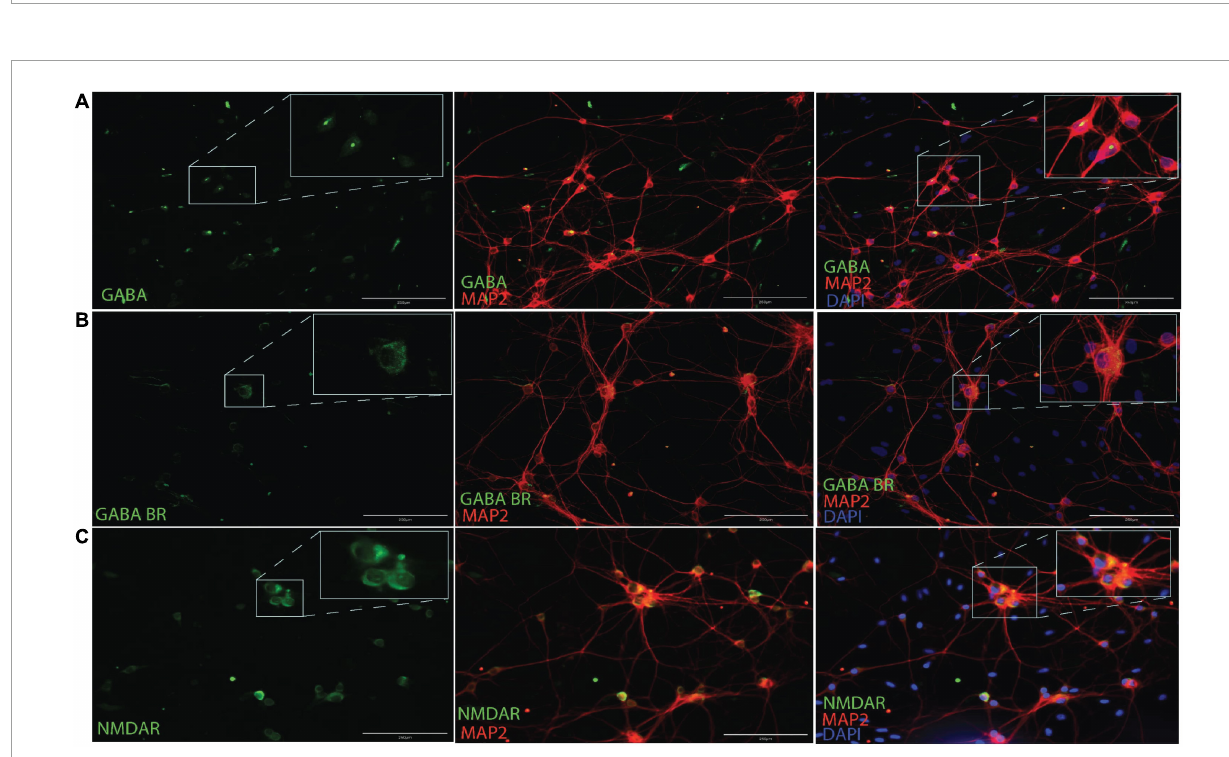
FIGURE4 Immunocytochemistry for GABA (A) , GABAB receptors (B) and NMDA receptors (C) along with MAP2 neuronal cytoskeletal marker at 14 DIV. Scale bar = 200 µ m.